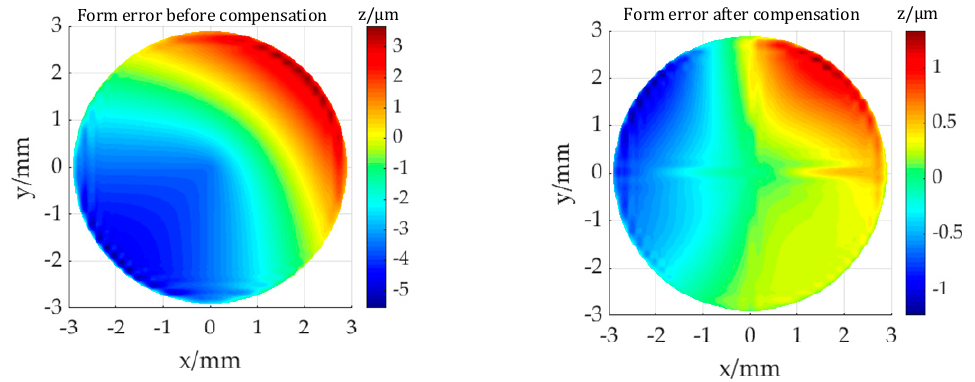
Figure 6. Form error of the machined toric surface: ( a ) before compensation; ( b ) after compensation.